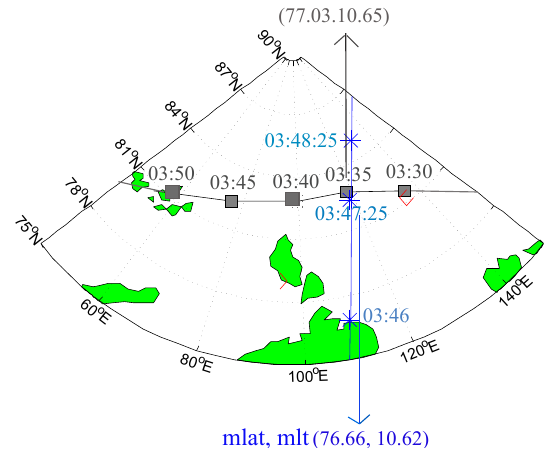
Figure 8. Satellite footprints in geographical coordinates for 17 July 2008: blue star is for CHAMP, grey squares are for Cluster 3. Colours of times in the plot correspond to the colours of satel- lite’s footprints. Arrows point to magnetic latitude and magnetic lo- cal time for satellites in conjunction.